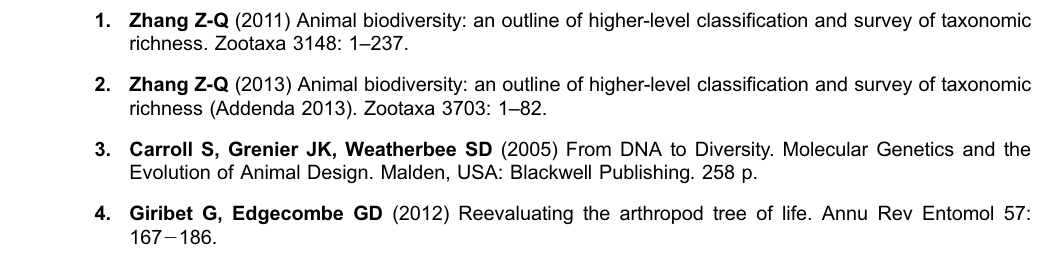
Figure S4. Expression of wingless and hedgehog in embryos of E. rowelli . Leg segments of stage IV embryos in ventral view. Note that the hedgehog stripes are located posterior to the corresponding wingless domains. Abbreviation: le , legs. Scale bars: 100 m m (A, B). Table S1. List of species and genes with corresponding accession numbers used for phylogenetic